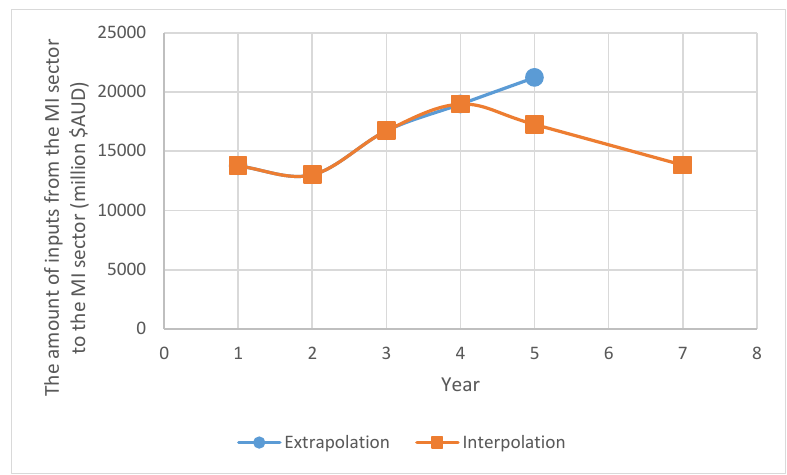
Figure 1. The comparative analysis for inputs from the MI sector to the MI sector. Mining = MI.